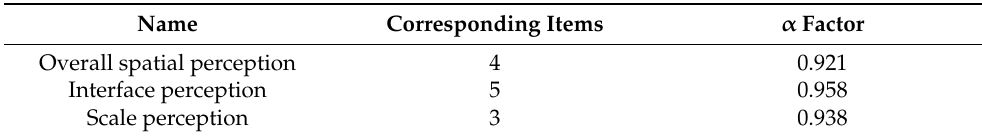
Table 2. Cronbach reliability analysis.